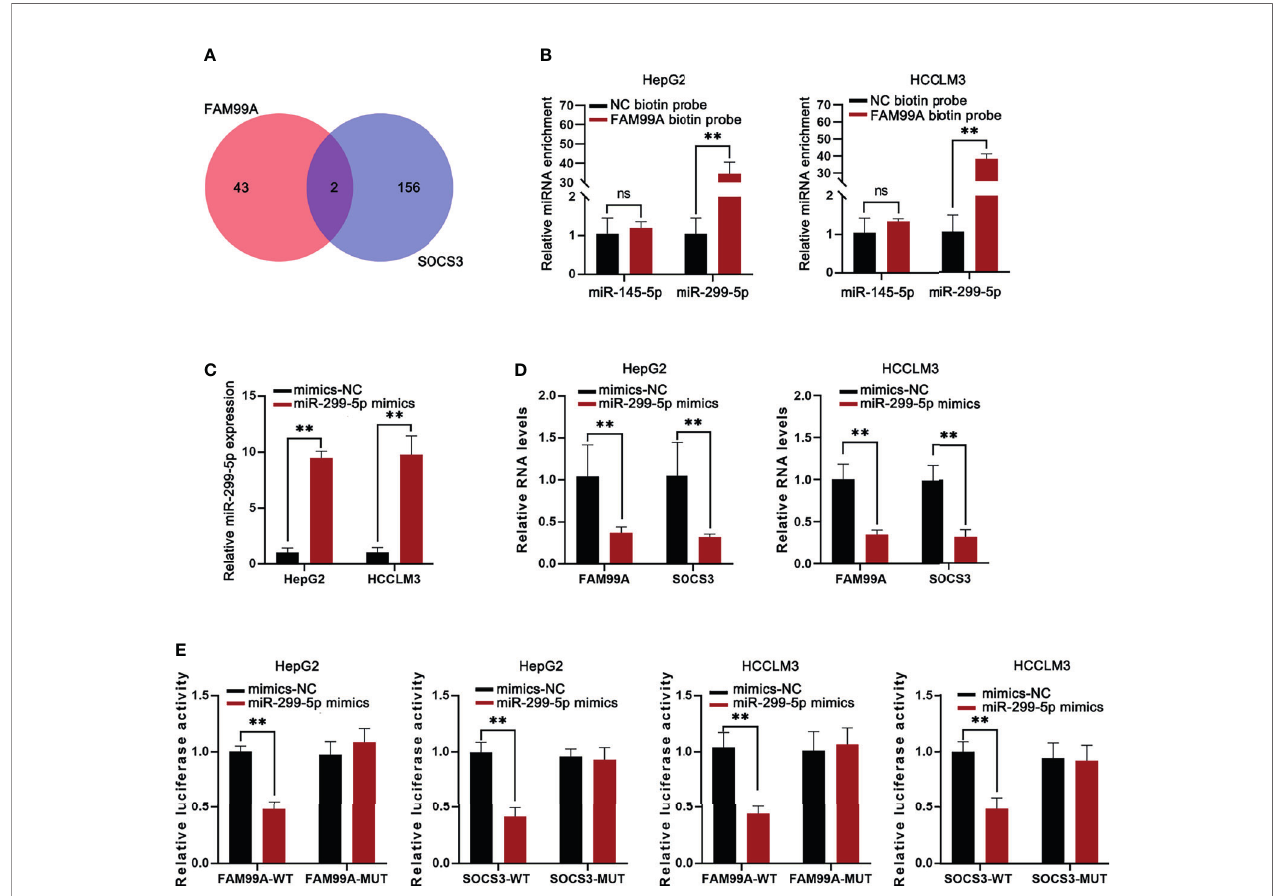
FIGURE 6 | FAM99A blocked the JAK2/STAT3 pathway via promoting SOCS3. (A) miRNAs binding to both FAM99A and SOCS3 in HCC cells were sorted. (B) RNA pull-down assay was conducted to detect the enrichment of miR-145-5p and miR-299-5p in the pull-down of biotinylated FAM99A in HCC cells. (C) The overexpression ef fi ciency of miR-299-5p was detected by qRT-PCR. (D) Expression of FAM99A and SOCS3 in HepG2 cells transfected with miR-299-5p mimics was detected. (E) Luciferase reporter assay was used to verify the relationship between FAM99A/SOCS3 and miR-299-5p. ** p < 0.01, ns, no signi fi cance.